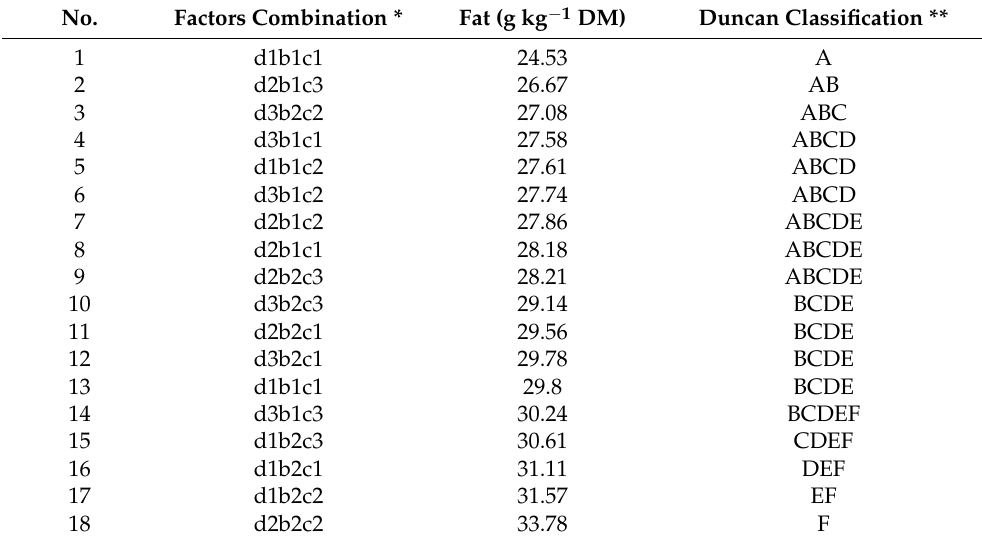
Table 6. Synthesis of soybean fat content (g kg − 1 DM) comparisons by technological factors (Duncan classification of the average values for 2017–2019).